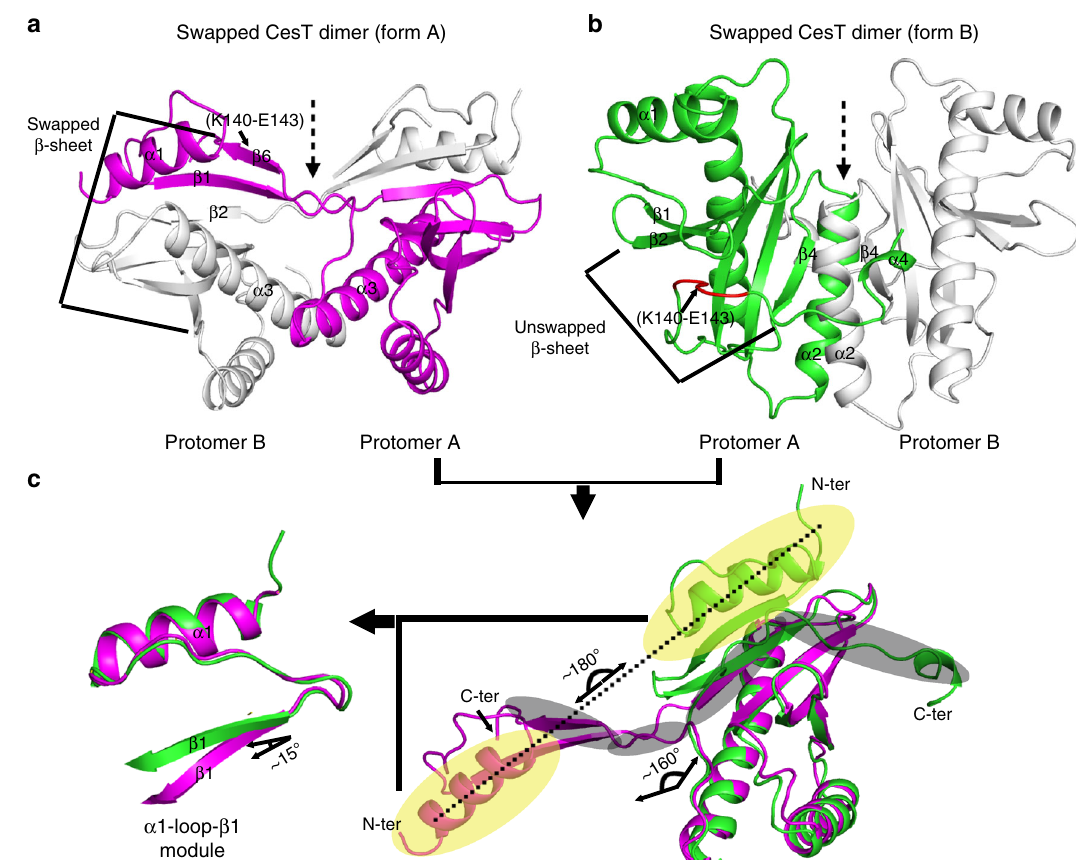
Fig. 3 Two distinct domain-swapped dimeric architectures of CesT. a The form A dimeric architecture (based on PDB code: 1K3E). b The form B dimeric architecture (based on the complex structure solved in the current study). Those secondary structure elements referred to in the text are labeled. The swapped β -sheet in the dimer form A and the unswapped β -sheet in the dimer form B are highlighted. Residues K140-E143, which adopt a rigid strand conformation in dimer form A but exhibit a loop structure in dimer form B, were marked and colored red in b for clarity. The two-fold rotation axes are shown as dashed arrows. c Comparison of the single protomer structures derived from the two forms of CesT dimers. The N-terminal α 1-loop – β 1 module and the extended C-terminal motif are shaded in yellow and in gray, respectively. The profound orientation-divergences are marked. The N-module is further superimposed to highlight their overall similar folds but a slight orientation-difference in strand β